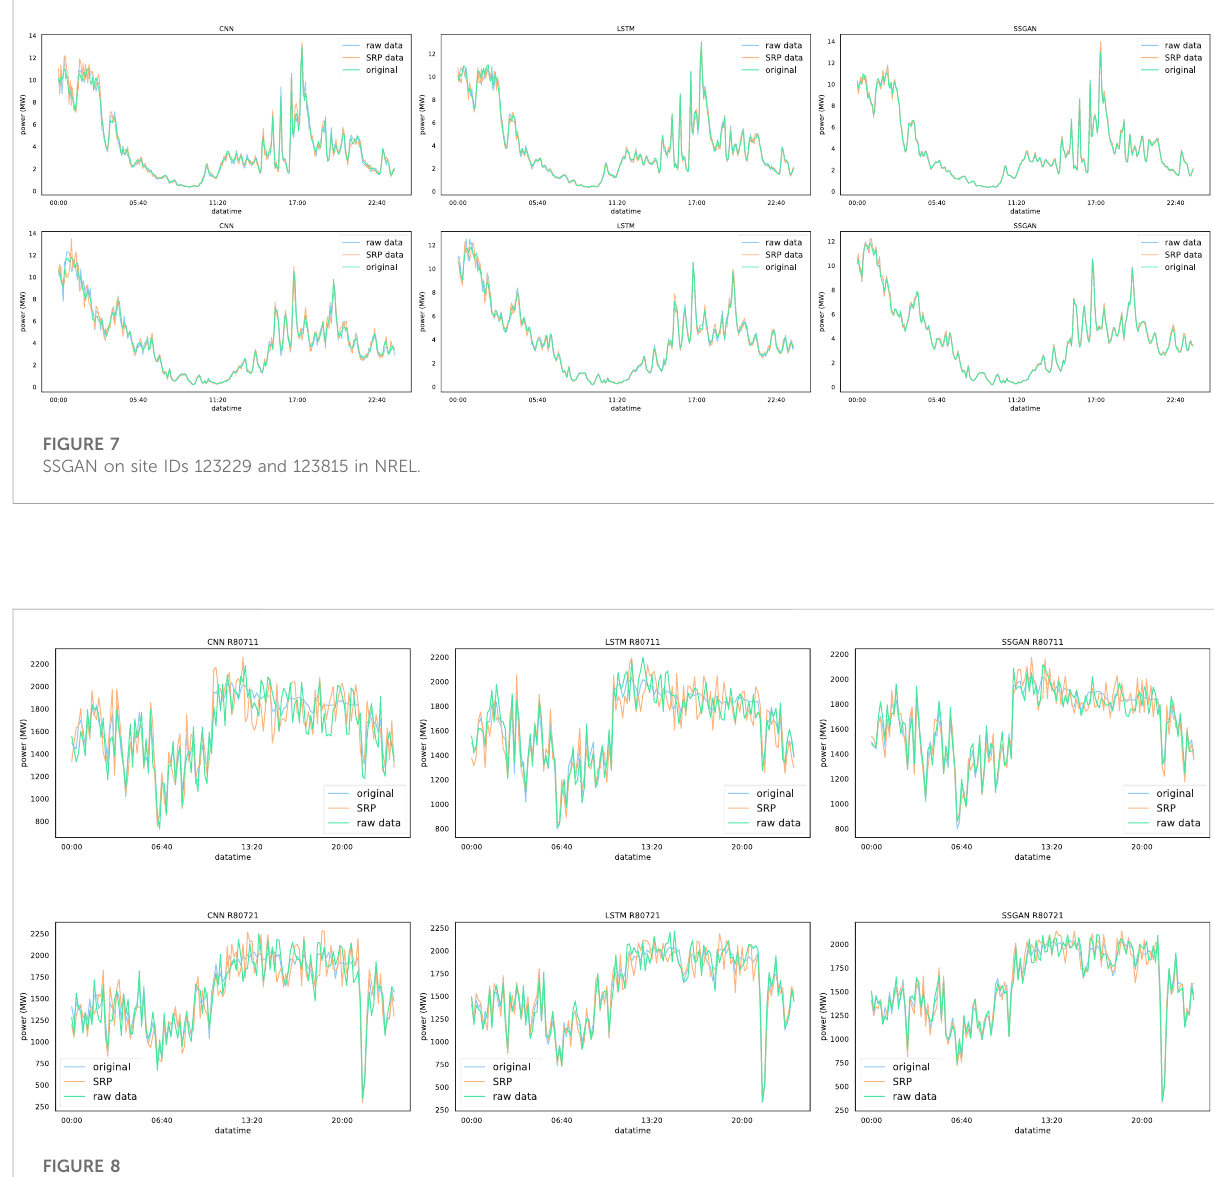
FIGURE 8 SSGAN on site IDs R80711 and R80721 in